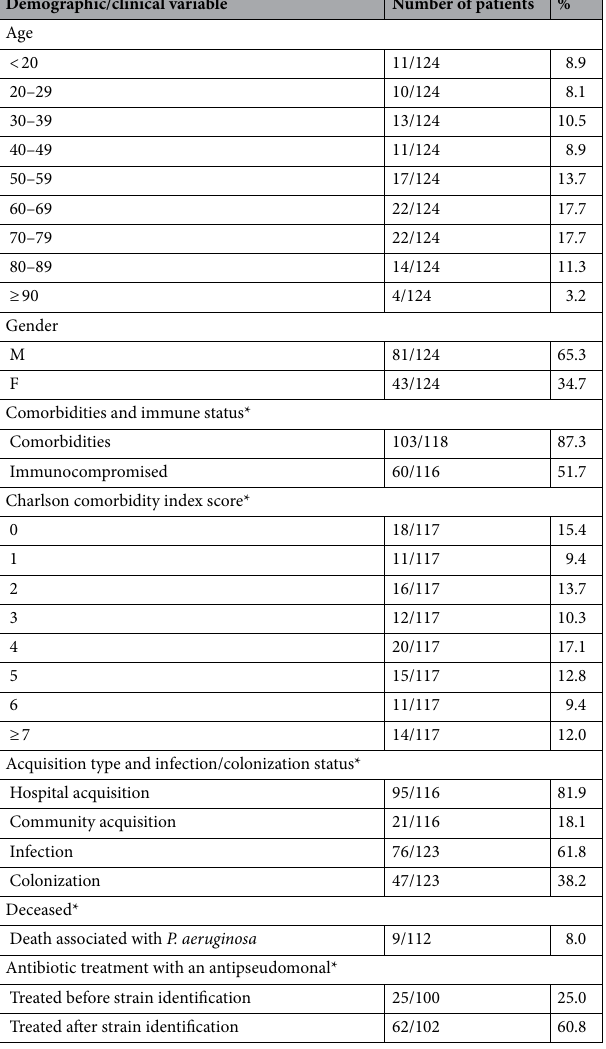
Table 1. Demographic and clinical characteristics of patients associated with the P-strains (n = 124) from the study panel. *Not found cases were excluded from the